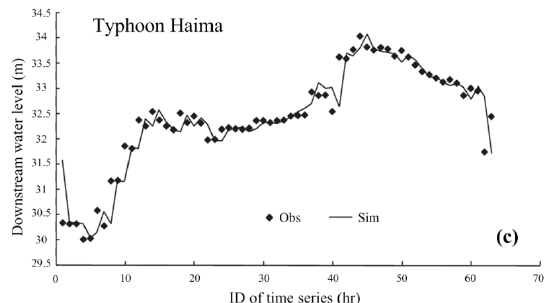
Figure 10. Relationships between simulated and observed water levels at San-Ying Bridge during the construction process of the BPNN-based model: ( a ) single-moment training; ( b ) single-moment validation; and ( c ) complete-event verification.